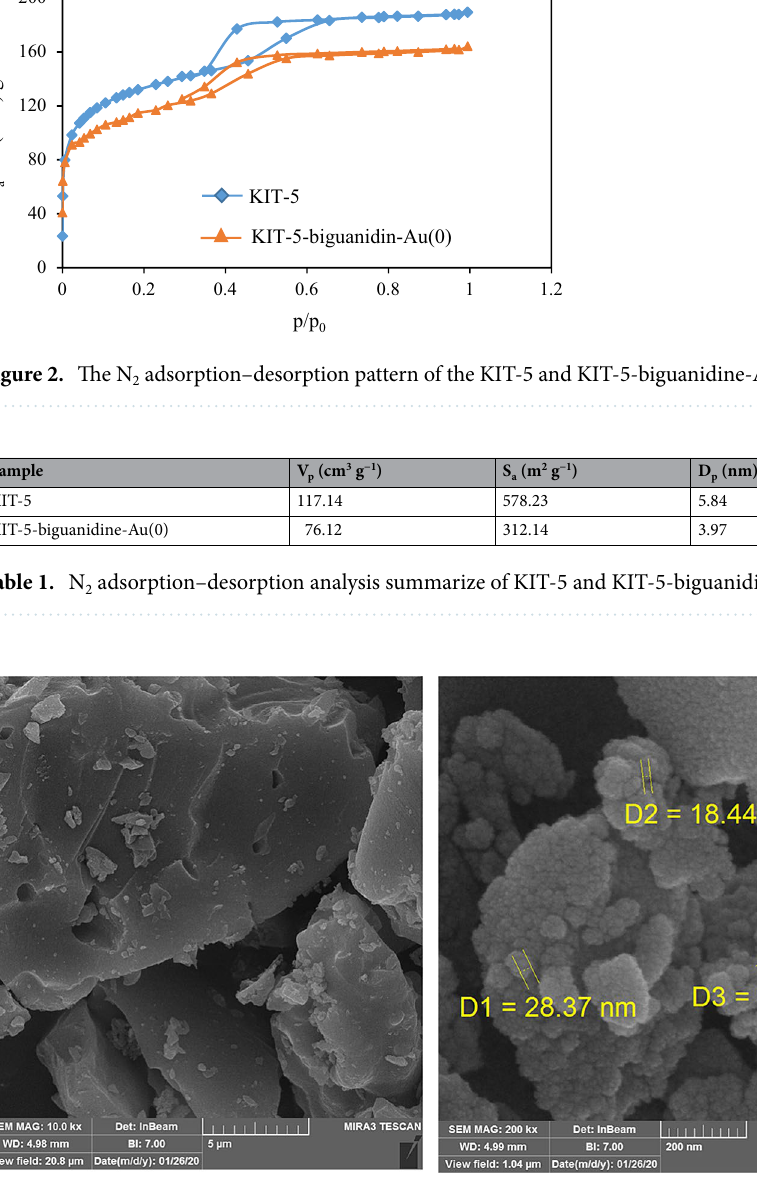
Figure 3. The SEM image of KIT-5-biguanidine-Au (0)